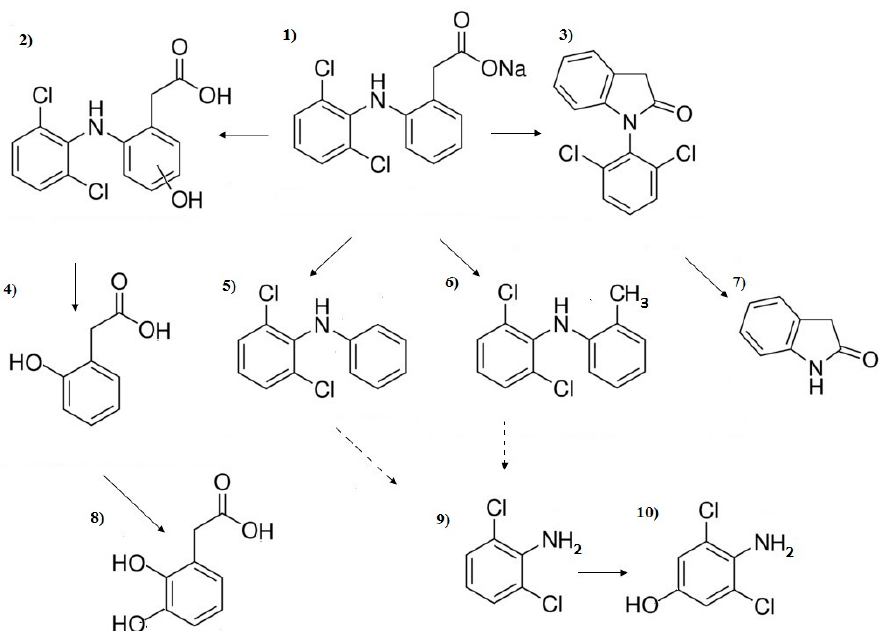
Figure 6. Possible degradation pathway of 1 diclofenac sodium salt where 2 4 ′‐ hydroxydiclofenac, 3 1 ‐ (2,6 ‐ dichlorophenyl) ‐ 2 ‐ indolinone, 4 2 ‐ hydroxyphenylacetic acid, 5 2 ‐ dichlorodiphenylamine, 6 N ‐ (2,6 ‐ dichlorophenyl) ‐ 2 ‐ aminotoluene, 7 2 ‐ indolinone, 8 2,3 ‐ dihydroxyphenylacetic acid, 9 2,6 ‐ dichloroaniline and 10 4 ‐ amino ‐ 3,5 ‐ dichlorophenol.